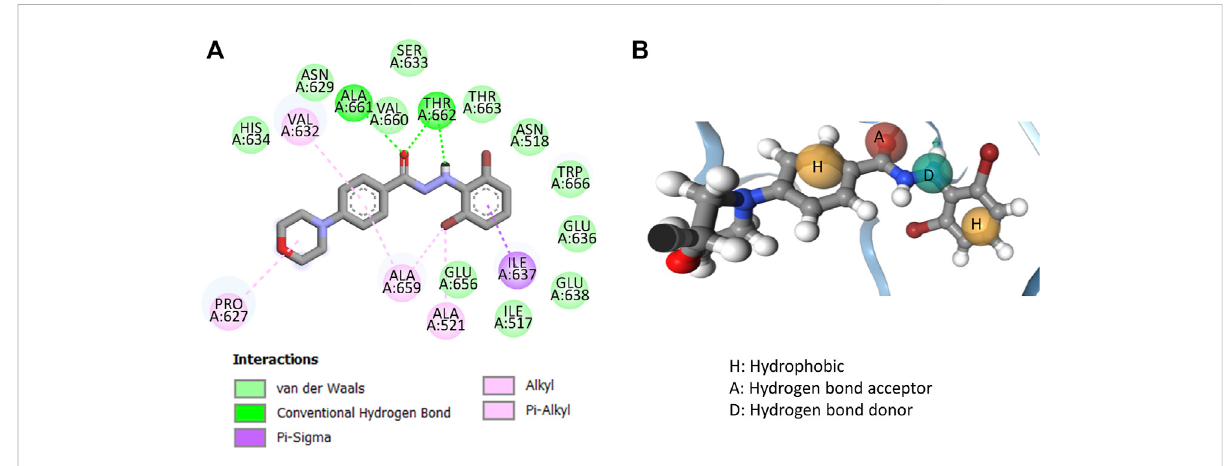
FIGURE 6 (A) Interactions obtained from molecular docking of compound 11q with the RdRp receptor (PDB: 6QPF) and (B) structure-based pharmacophore mapping aligned with 11q